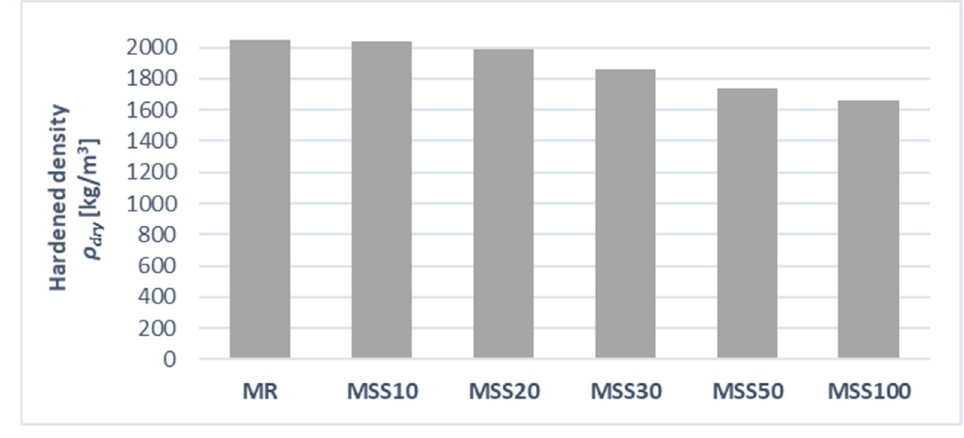
Figure 9. Hardened density of mortars.